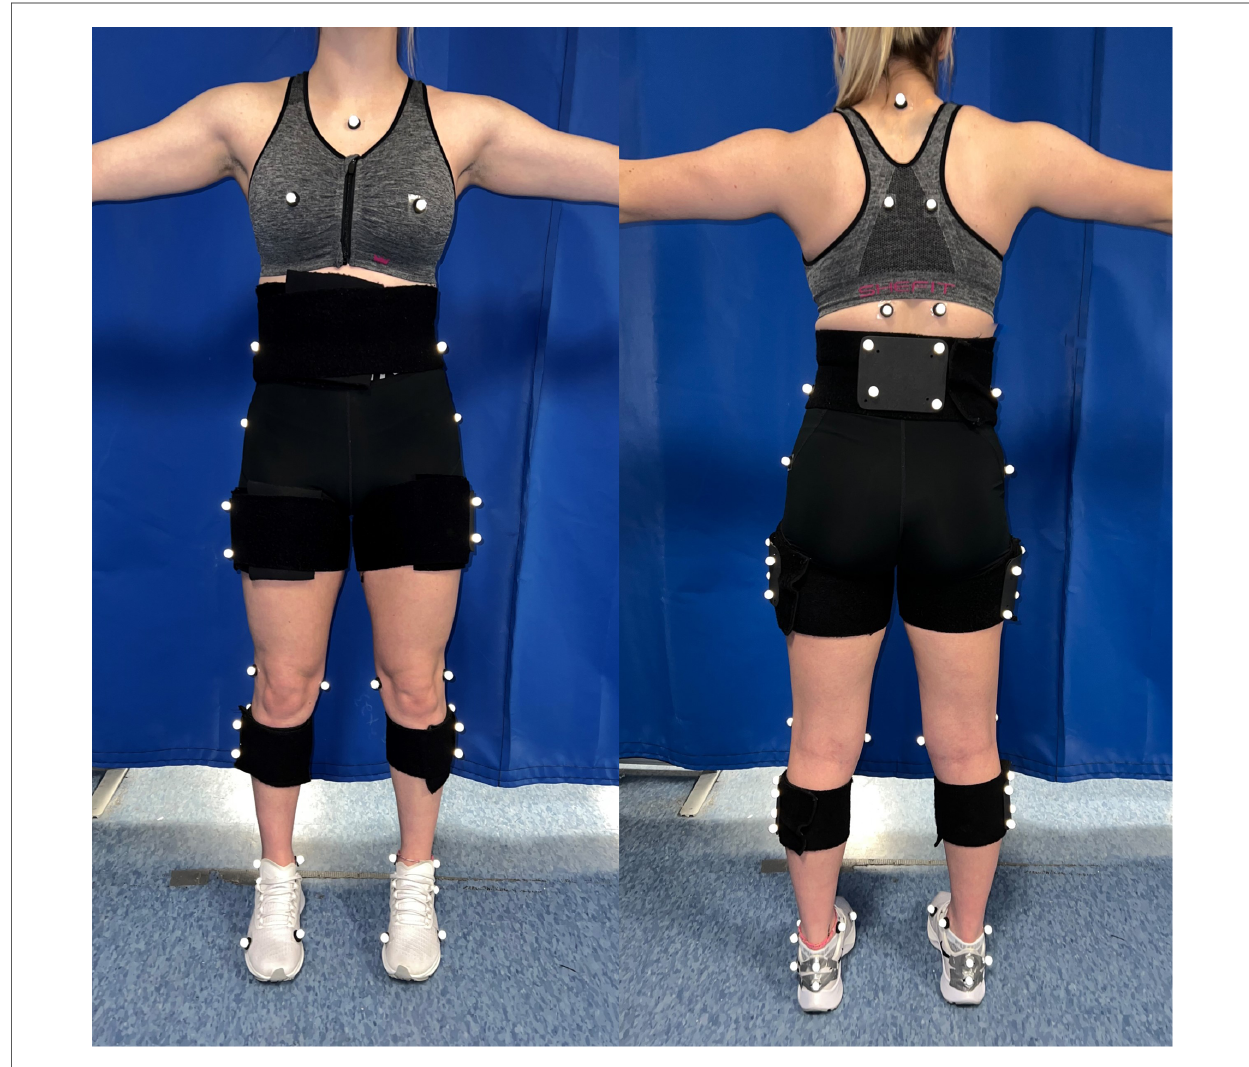
FIGURE 1 An image depicting the marker set used to evaluate lower extremity biomechanics and breast displacement relative to the